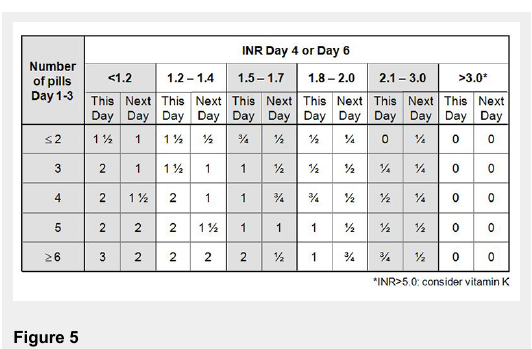
Revised dosing algorithm for days 4 and